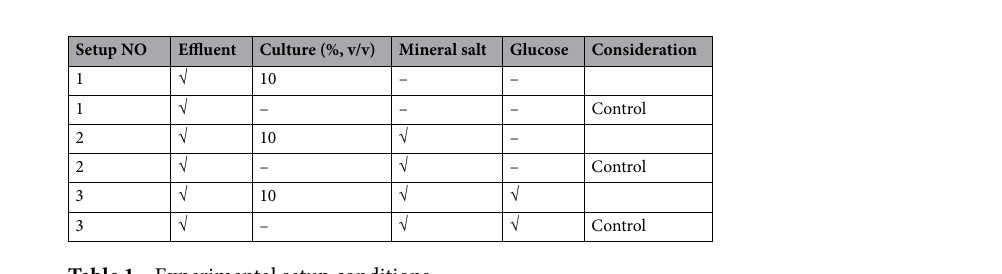
Table 1. Experimental setup